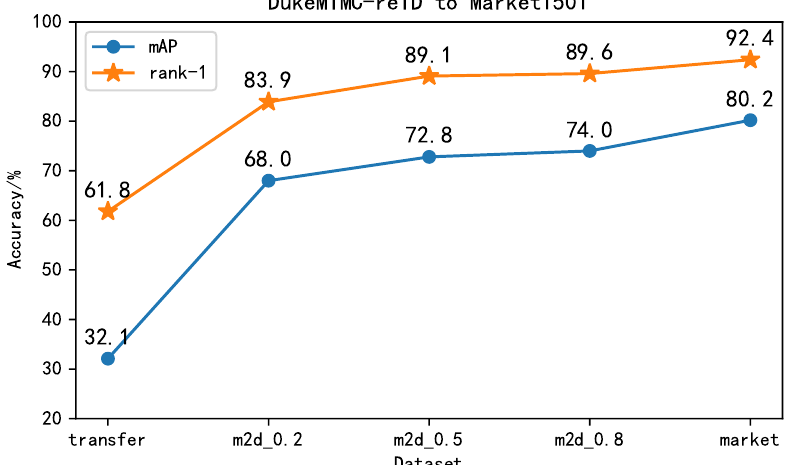
Figure 7. The results of ablation experiments for DukeMTMC-reID to Market1501 dataset. Transfer represents the model trained on source domain and then directly evaluated on target domain. m2d_0.2 denotes that we conducted UDA baseline on intermediate domain with λ = 0.2.